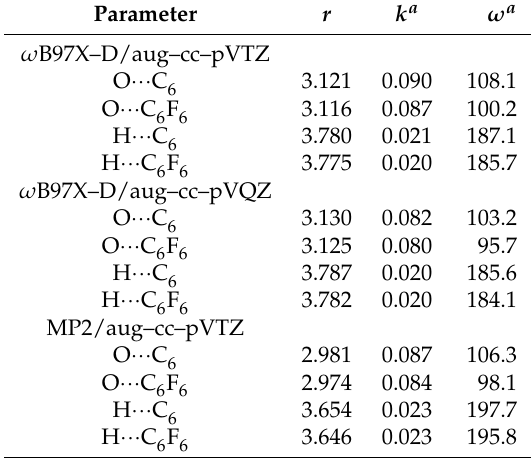
6 F denotes similar as above 6 6 denotes one acceptor H–atom interacting 6 F represents the aforementioned 6 6